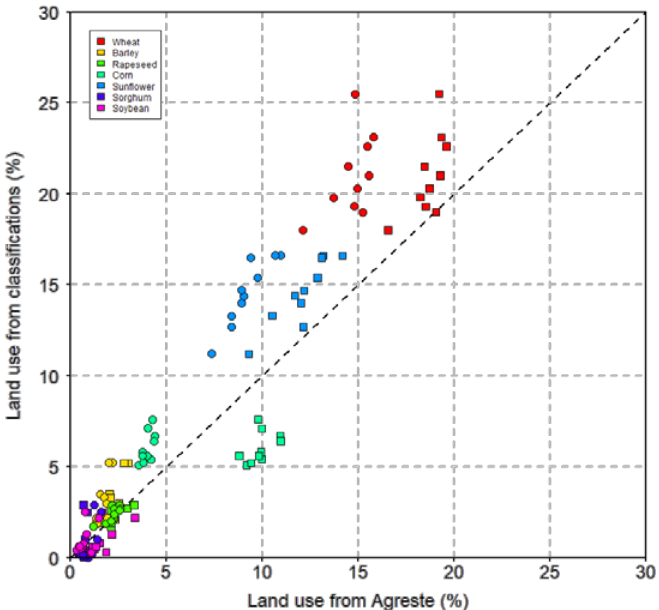
Figure 6. Comparison between the percent of surface allocated to the 7 classes of crop derived from the land use classifications and statistics presented by the French ministry of agriculture and food for the Gers and Haute Garonne counties (squares and circles, respectively).